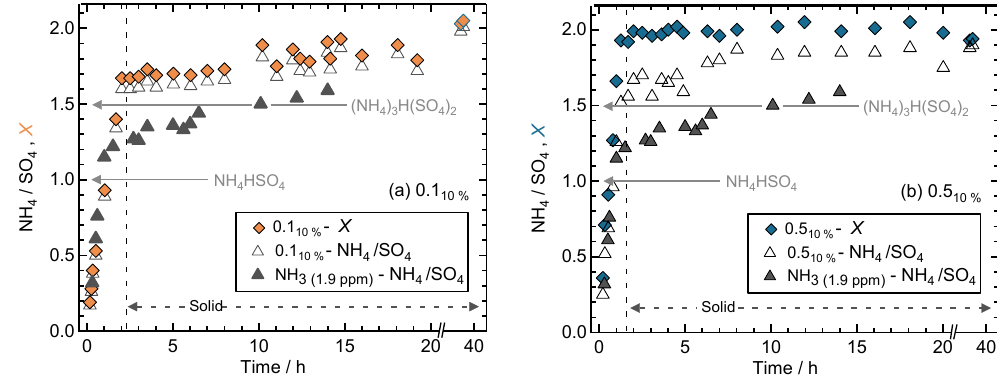
Figure 5. Comparison of particulate NH 4 / SO 4 in single-gas uptake (filled triangles) vs. DMA–NH 3 co-uptake (open triangles) experiments at 10% RH into H 2 SO 4 : (a) DMA / NH 3 = 0 . 07, and (b) DMA / NH 3 = 0 . 46. Diamonds denote the neutralisation ratio ( X ) in co-uptake experiments. Error bars are omitted for